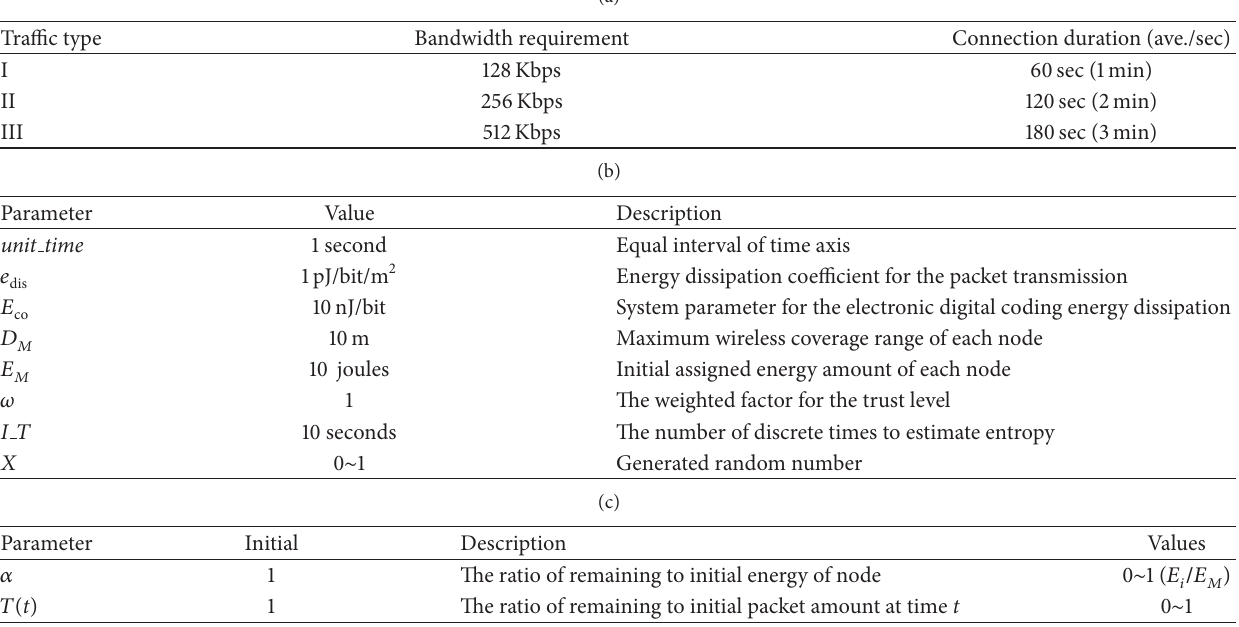
Table 1: Type of traffic and system parameters used in the simulation